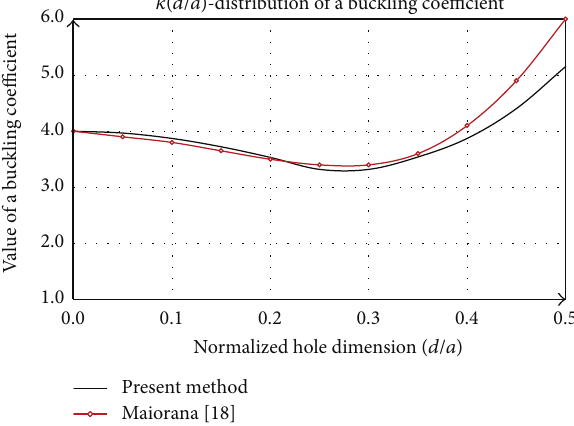
Figure 10: Comparative analysis of buckling coefficient of square plate with a slotted hole (horizontal position).